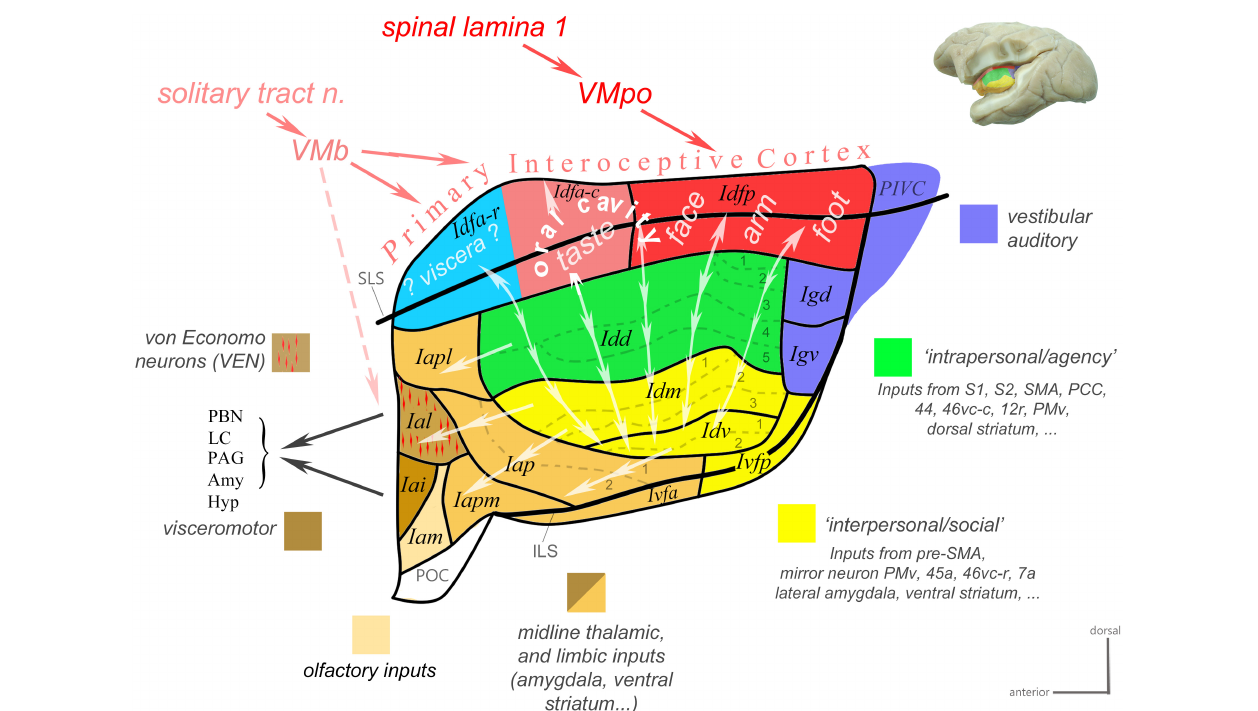
FIGURE 3 | Working functional model of the macaque insula. Color-coded flat map of the insula showing a possible functional organization inscribed within the modular architectonic Bauplan . Idfa and Idfp form the “Primary Interoceptive Cortex,” which receives vagal and spinal interoceptive afferents from the solitary tract nucleus and lamina 1 of the spinal cord, via the basal and posterior parts of the ventral medial nucleus of the thalamus (VMb and VMpo), respectively. The sensory interoceptive afferents are somatotopically organized from posterior (foot-to-head, red) to mid (orofacial cavity, pink) to anterior (viscera, blue). The vertical double-ended arrows represent the homotopic transfer of information from the primary interoceptive cortex to the distinct modules of the dysgranular areas. We distinguish two main dysgranular domains: (Craig, 2009) an “intrapersonal” domain (green) integrating interoceptive activity with inputs from cortical and subcortical regions involved in the proprioceptive control of movements; (Critchley and Garfinkel, 2018) an “interpersonal” domain (yellow) integrating interoceptive activity with inputs from cortical and subcortical regions involved in the visuomotor and audiomotor control of movements, in particular when the visual or auditory stimulus relate to a conspecific (e.g., vocalization or facial stimulus). Together with the parieto-insular vestibular cortex (PIVC), the dorsal and ventral granular areas (Igd and Igv; blue) integrate vestibular, auditory, whole-body, and cardiovascular activity; they are likely interconnected with the dysgranular areas. The single-ended arrows represent the final funneling of information from the dysgranular modules to the agranular areas. Most agranular areas, including the VEN area, receive moderate sensory visceral afferents from VMb. At least the VEN area (Ial) and its neighbor (Iai) project directly to the parabrachial nucleus (PBN), and periaqueductal gray (PAG). Adapted with permission from Evrard